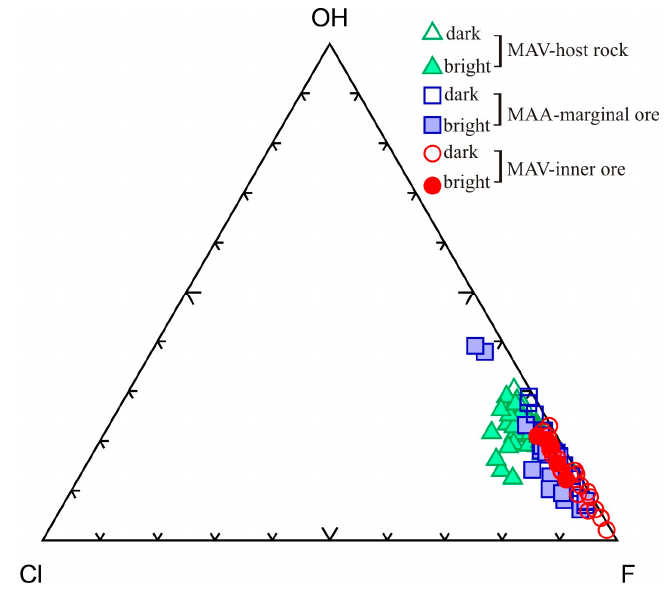
Figure 9. Ternary plot for bright and dark apatite areas from different apatite types from the Chadormalu ores and host rocks in terms of F-OH-Cl atomic proportions. Table 2. EPMA data (wt %) for bright and dark apatites from Chadormalu MAV-host rock apatite type.